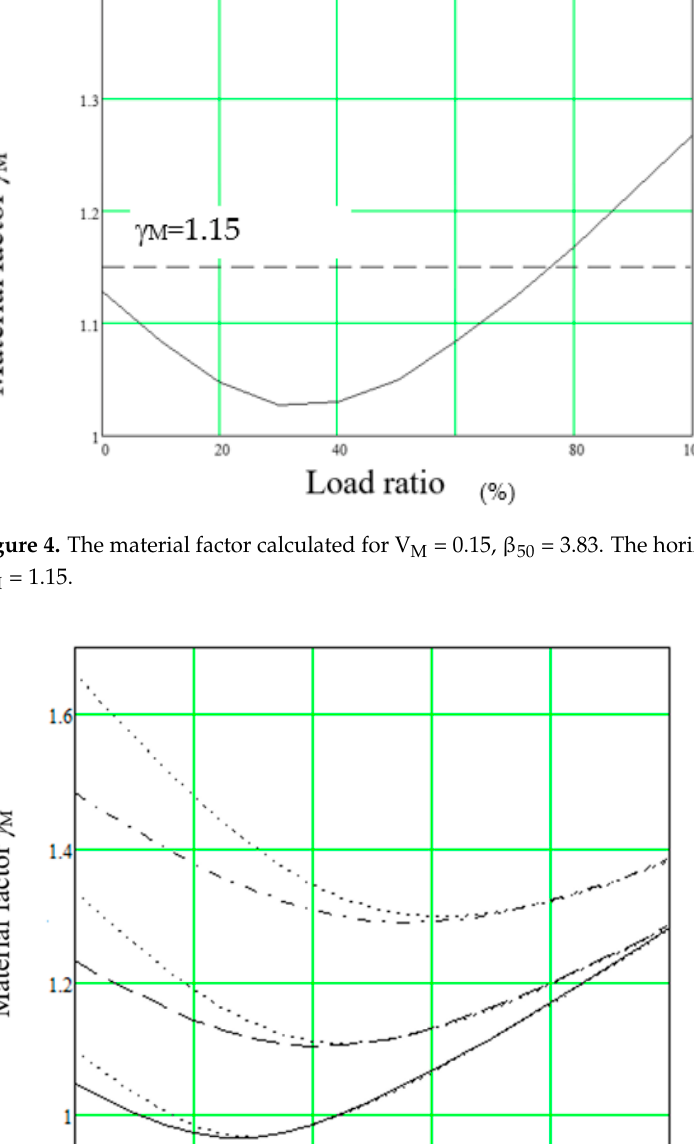
Figure 5. Material factors γ M of the current Eurocodes using the combination rule (8.12). Solid line, steel; dashed line, timber; and dash-dotted line, concrete. The dotted lines denote the safety factors of the one-year calculation.